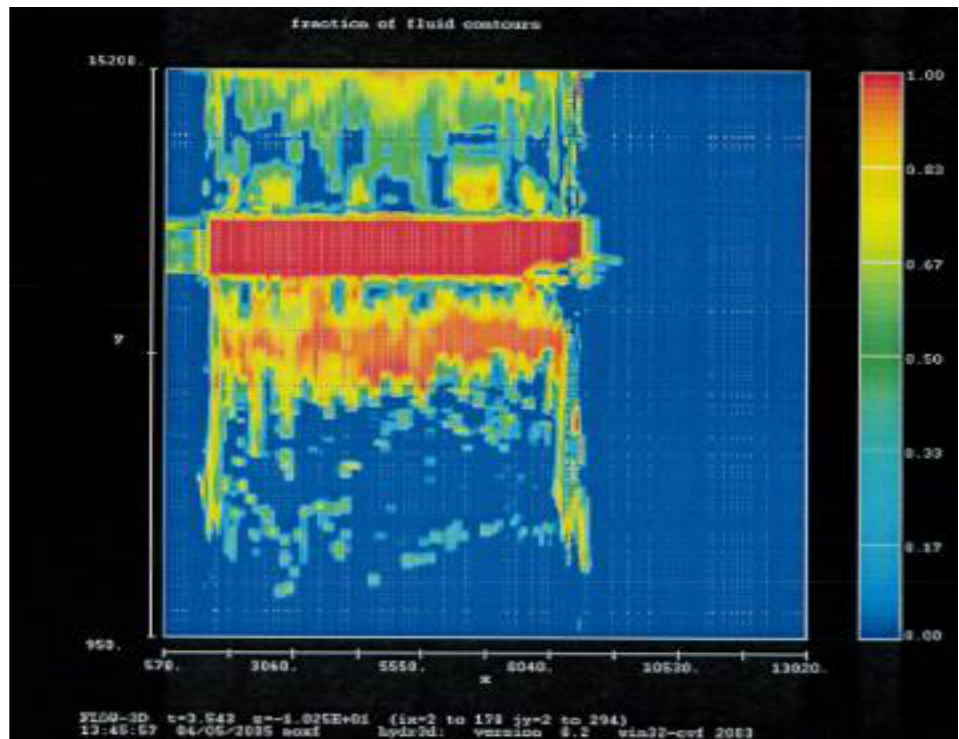
Figure 21. Aquifer fluid fraction ff concentration at 1.07 m below the southern farm area surface 3.54 months after the monsoon season ends. Note the later groundwater supply from ingested rainfall from the northern mountain area contributing to the baray water supply. Color version added to [1], p. 367.